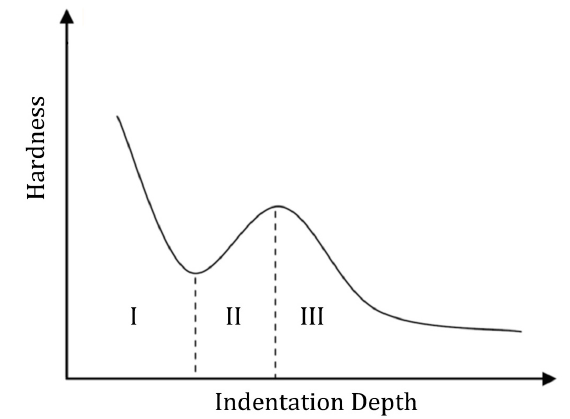
Figure 10. The typical nanoindentation response of polycrystalline samples.